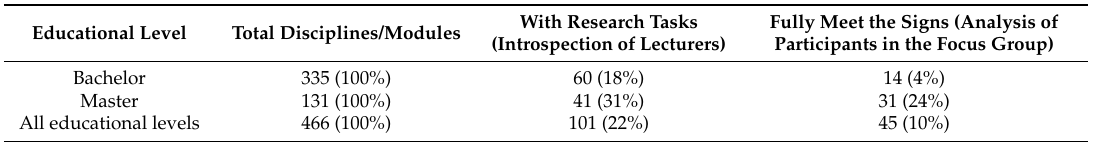
Table 2. Generalized results of educational programs